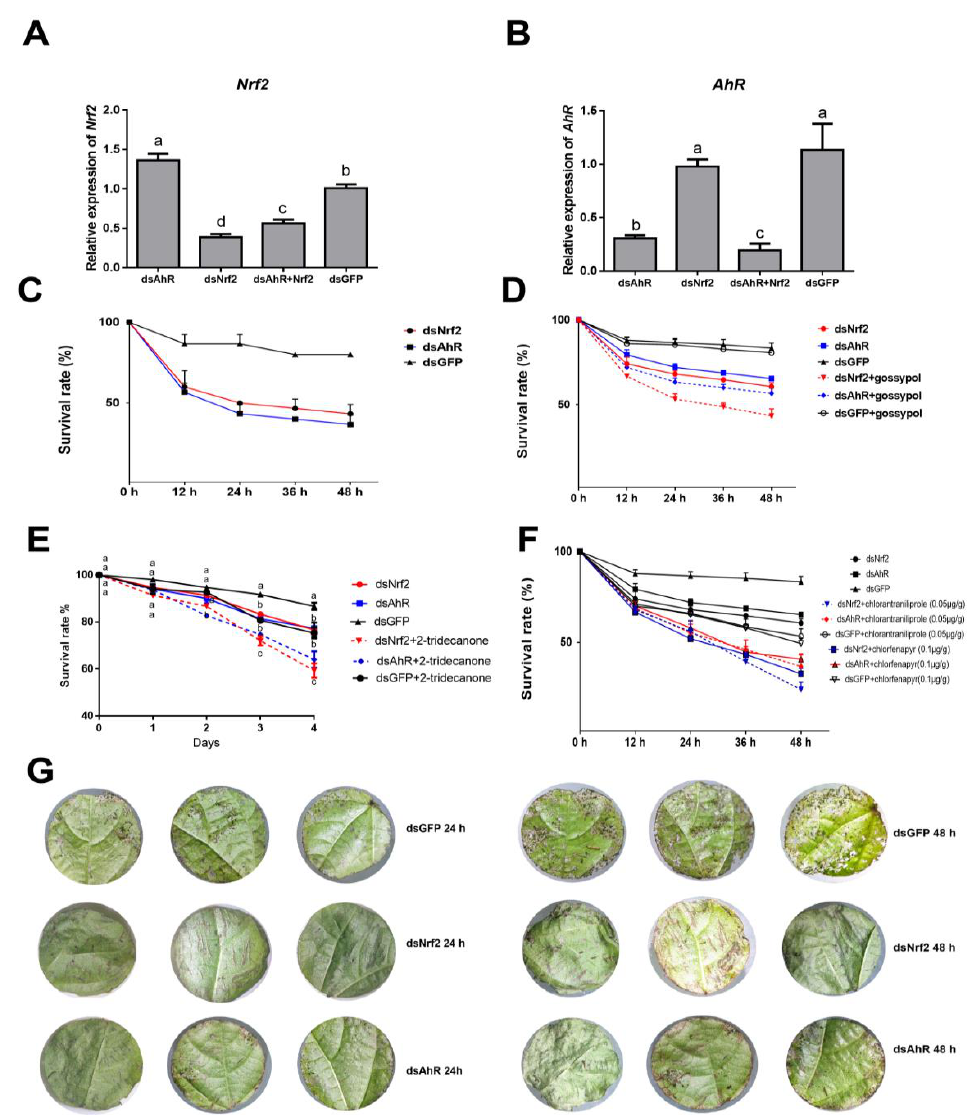
Figure 1. The effect on the susceptibility of xenobiotics by RNAi HaNrf2 and HaAhR in H. armigera. ( A ) RT-qPCR analysis of HaNrf2 gene expression after RNAi knockdown; ( B ) RT-qPCR analysis of HaAhR gene expression after RNAi knockdown; ( C ) mortality of H. armigera fed on cotton leaves coated with dsNrf2 or dsAhR; ( D ) mortality after HaNrf2 and HaAhR knockdown in H. armigera fed an artificial diet containing 0.02 mg/g gossypol; ( E ) mortality after HaNrf2 and HaAhR knockdown in H. armigera fed an artificial diet containing 0.05 mg/g 2-tridecanone; ( F ) mortality after HaNrf2 and HaAhR knockdown in H. armigera fed an artificial diet containing 0.05μg/g chlorantraniliprole or 0.1 μg/g chlorfenapyr; ( G ) resistance of dsNrf2 and dsAhR coated cotton leaves against H. armigera . Means and SEs from three biological replicates are shown. Different letters on error bars show significant differences ( p < 0.05).